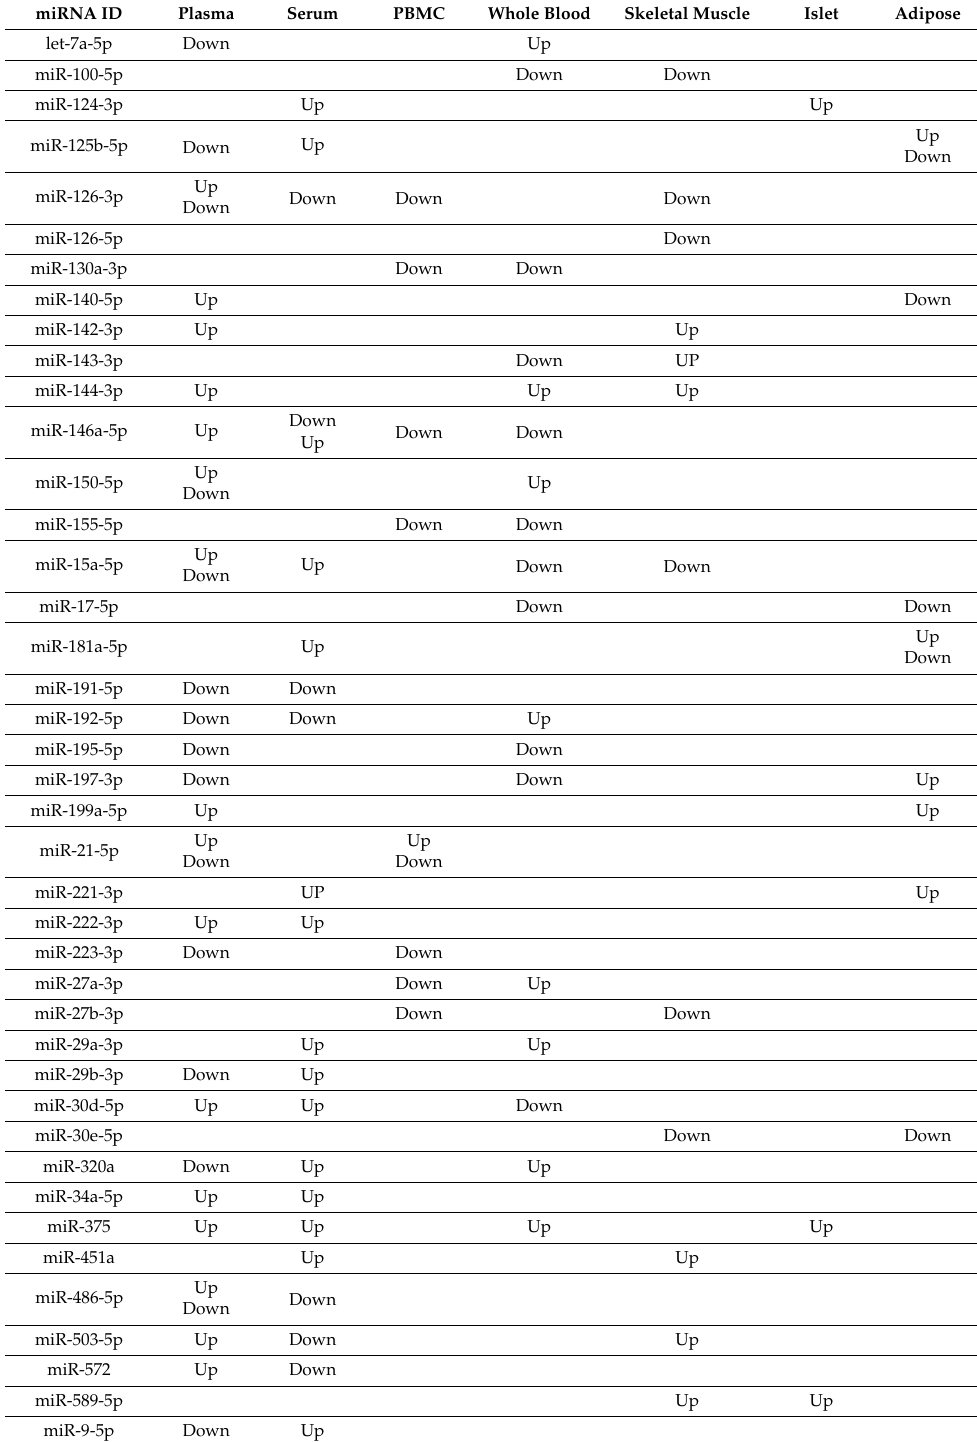
Table 3. Common changes of miRNAs in different sample